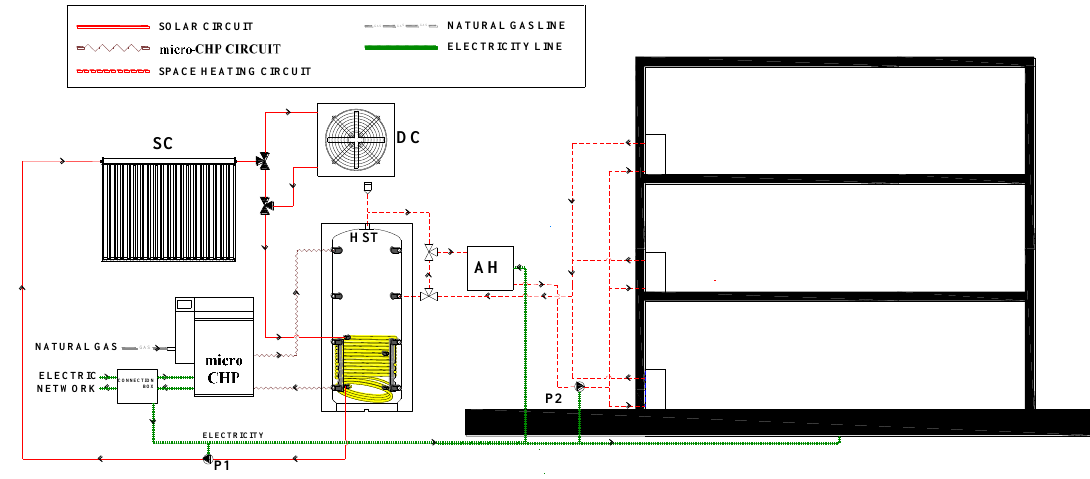
Figure 5. System configuration in cooling mode.